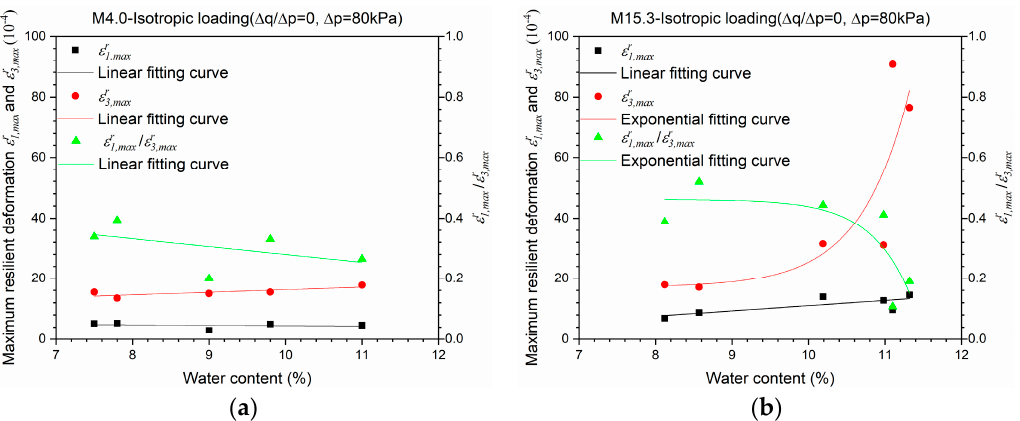
Figure 6. Maximum resilient deformations ε 1 ,maxr and ε 3 ,maxr for Missillac sands M4.0 and M15.3 in the isotropic loading stress path ( ∆ q / ∆ p = 0) for the resilient test phase. (a) M4.0; (b) M15.3.